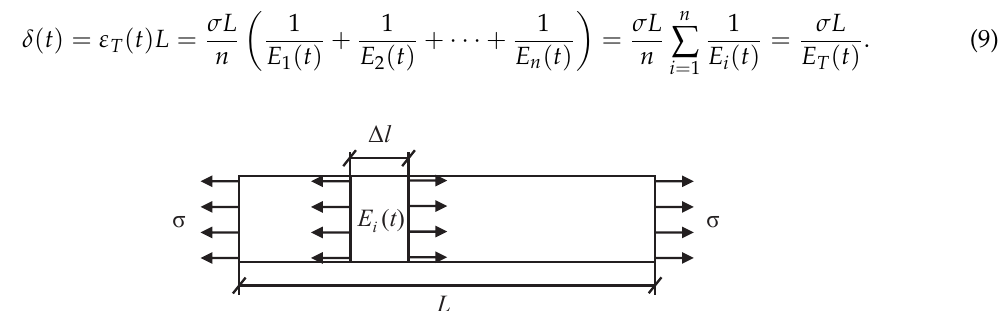
Figure 2. Schematic illustration of a specimen of length L subject to a constant stress σ , subdivided in n elements of equal length ∆ l